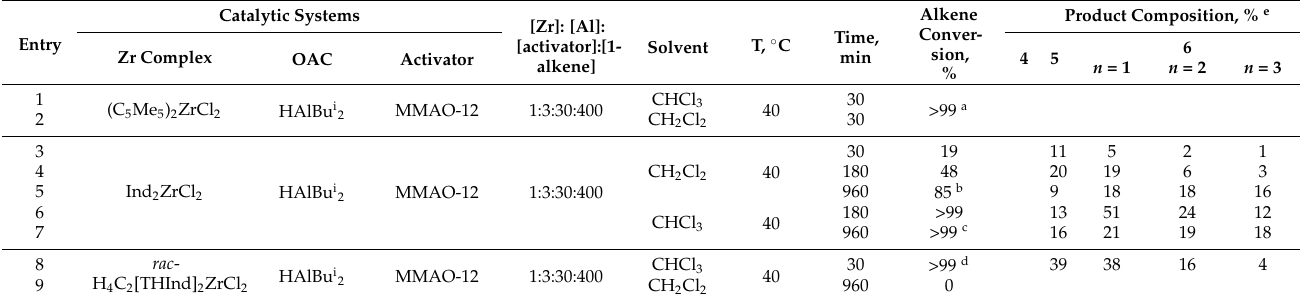
Table 3. Catalytic activity and chemoselectivity of systems L 2 ZrCl 2 -HAlBu i 2 -activator in the reaction with